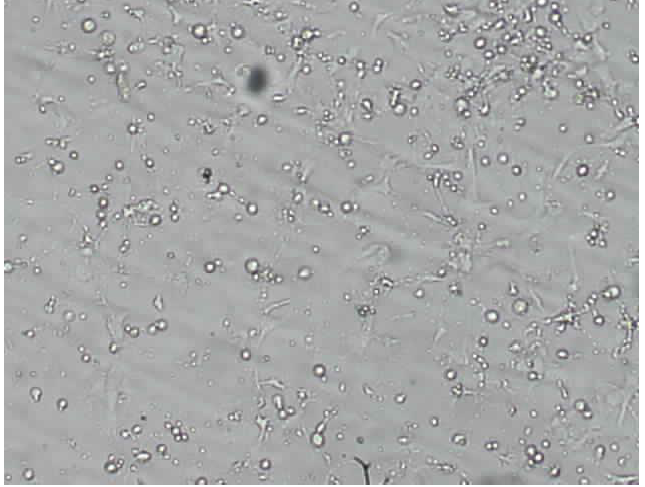
Figure 2 culture of secondary fetal ovine thyroid cells infected with FMDV (sample FMD Amoo3) 10 X